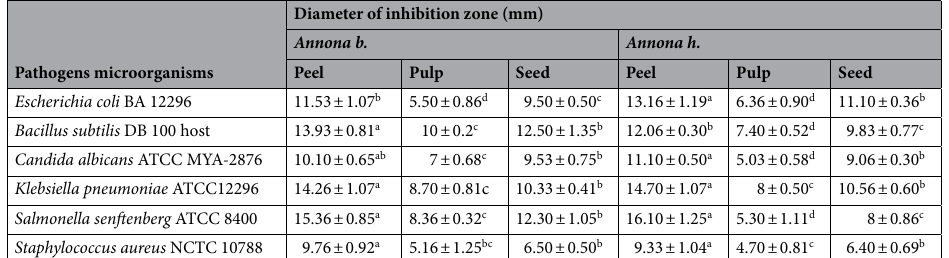
Diameter of inhibition zone (mm) Annona b. Annona Pathogens microorganisms